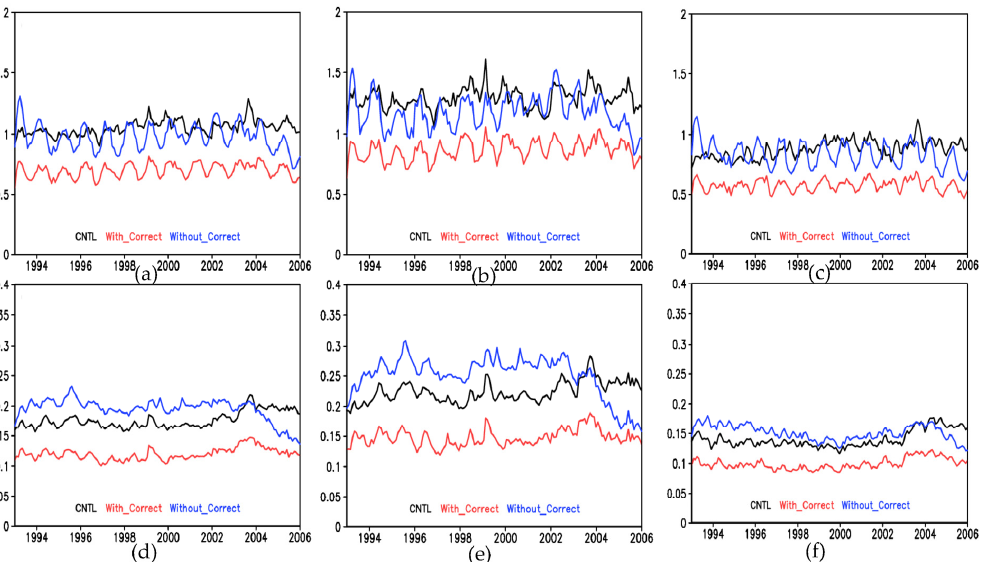
Figure 9. Time series of the RMSEs of HC300 ( a – c ) and SC300 ( d – f ) relative to EN4.2.2 in different ocean basins from different experiments. ( a , d ) Southern Indian and Southern Pacific oceans, ( b , e ) Southern Indian Ocean, ( c , f ) Southern Pacific Ocean.